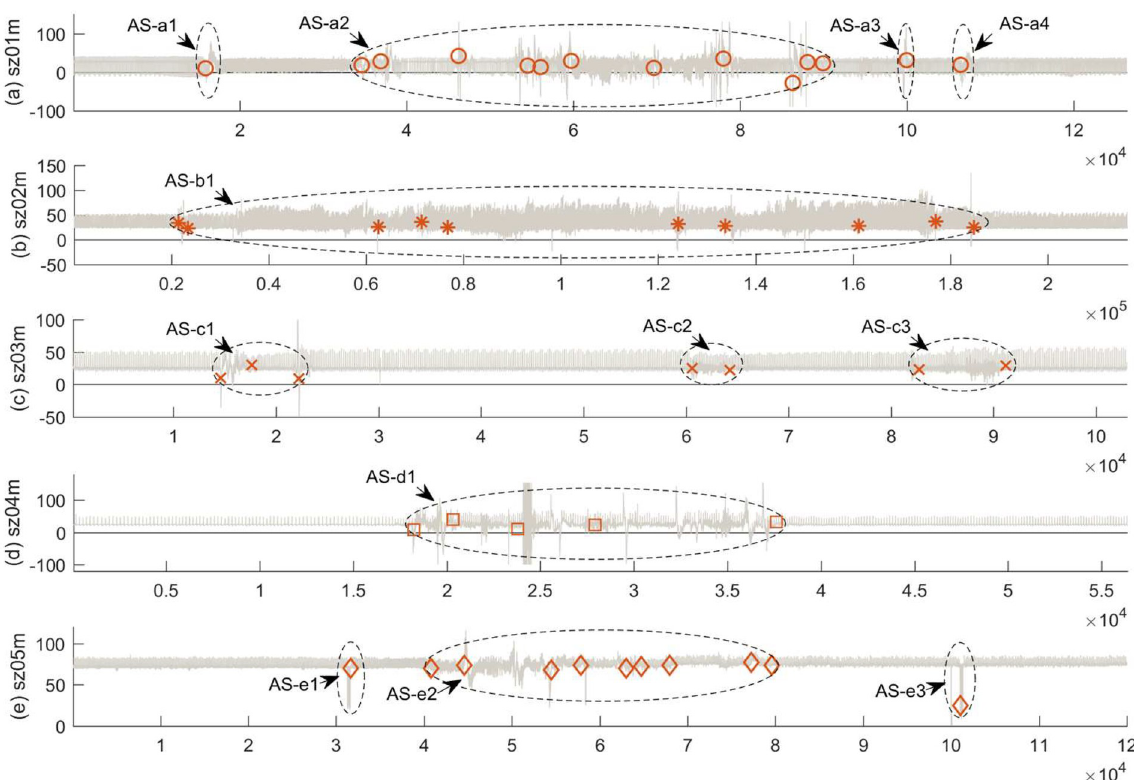
Fig 13. The results of MCPs detection on five ECG signals from sz01m to sz05m in the partial epilepsy databases. By using our RSW&TST framework, the resultant MCPs were detected on different ECG samples of patients in Post-Ictal Heart Rate Oscillations in the recordings of (A) sz01m, (B) sz02m, (C) sz03m, (D) sz04m, and (E) sz05m, respectively.